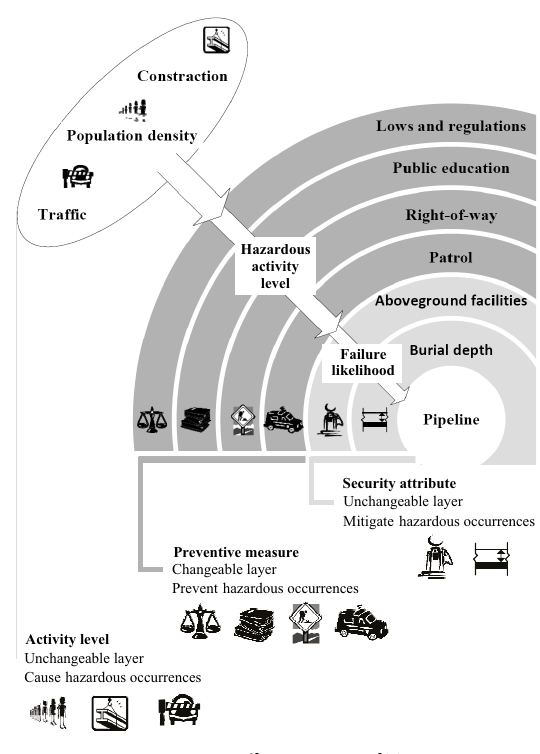
Fig. 5. Cause-effect process of